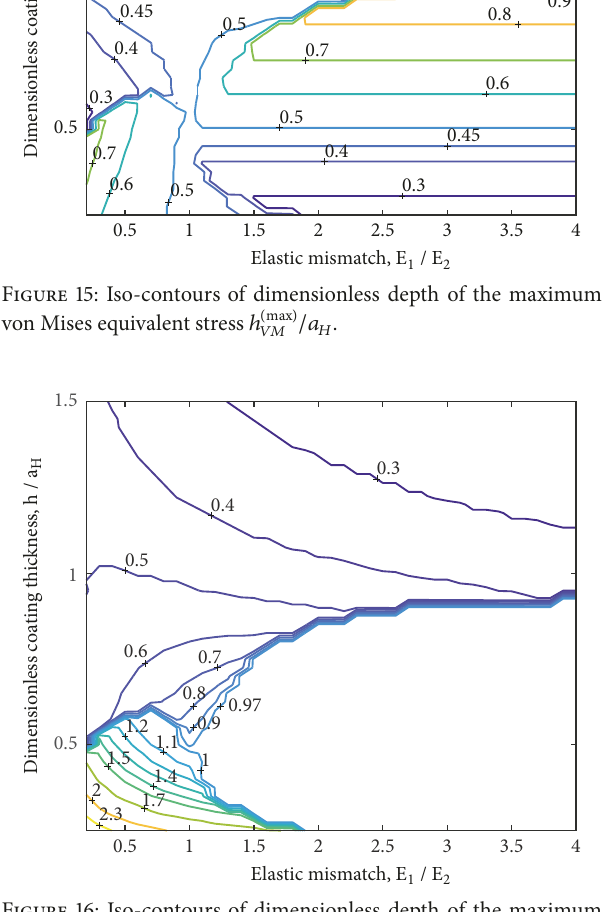
Figure 16: Iso-contours of dimensionless depth of the maximum von Mises equivalent stress ℎ ( max ) 𝑉𝑀 /ℎ